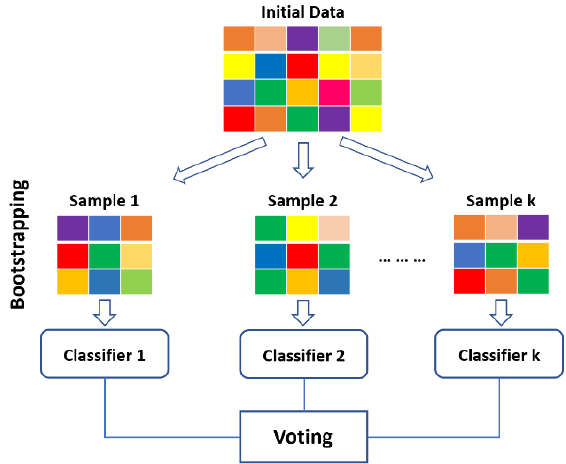
Figure 11. An illustration of the Bagging Technique [25].